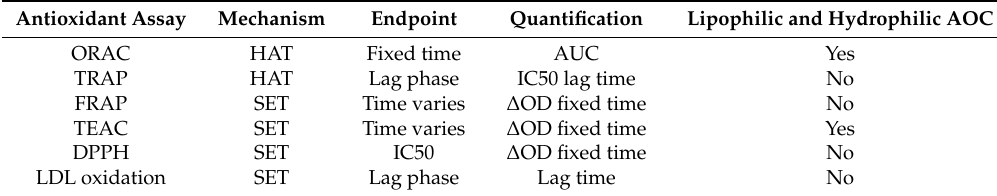
Table 1. Comparison of methods for assessing antioxidant capacity based upon mechanism, endpoint, quantitation method, and whether the assay is adaptable to measure lipophilic and hydrophilic antioxidants. Antioxidant Assay Mechanism Endpoint Quantification Lipophilic and Hydrophilic AOC ORAC HAT Fixed time AUC Yes TRAP HAT Lag phase IC50 lag time No FRAP SET Time varies ∆ OD fixed time No TEAC SET Time varies ∆ OD fixed time SET